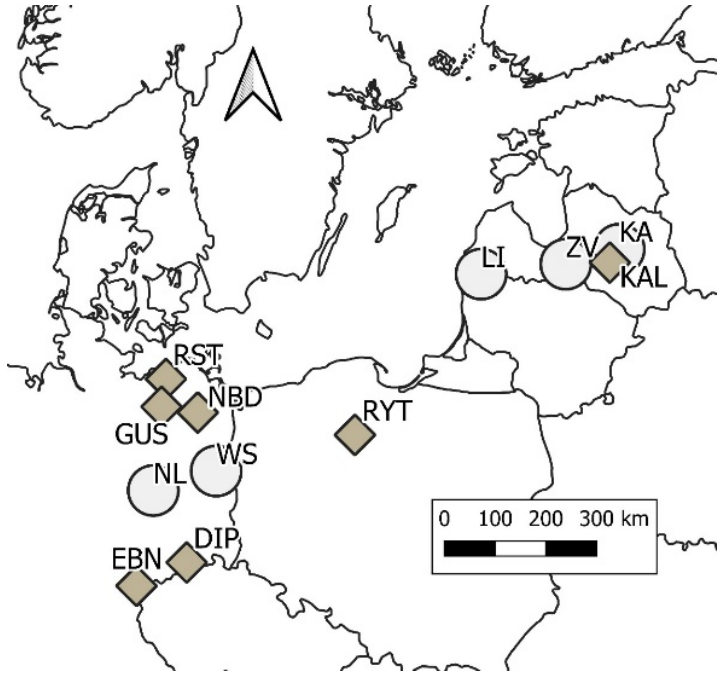
Figure 1. Location of the studied trials (circles) and origins of the studied provenances (squares) of the south ‐ eastern Baltic Scots pine.